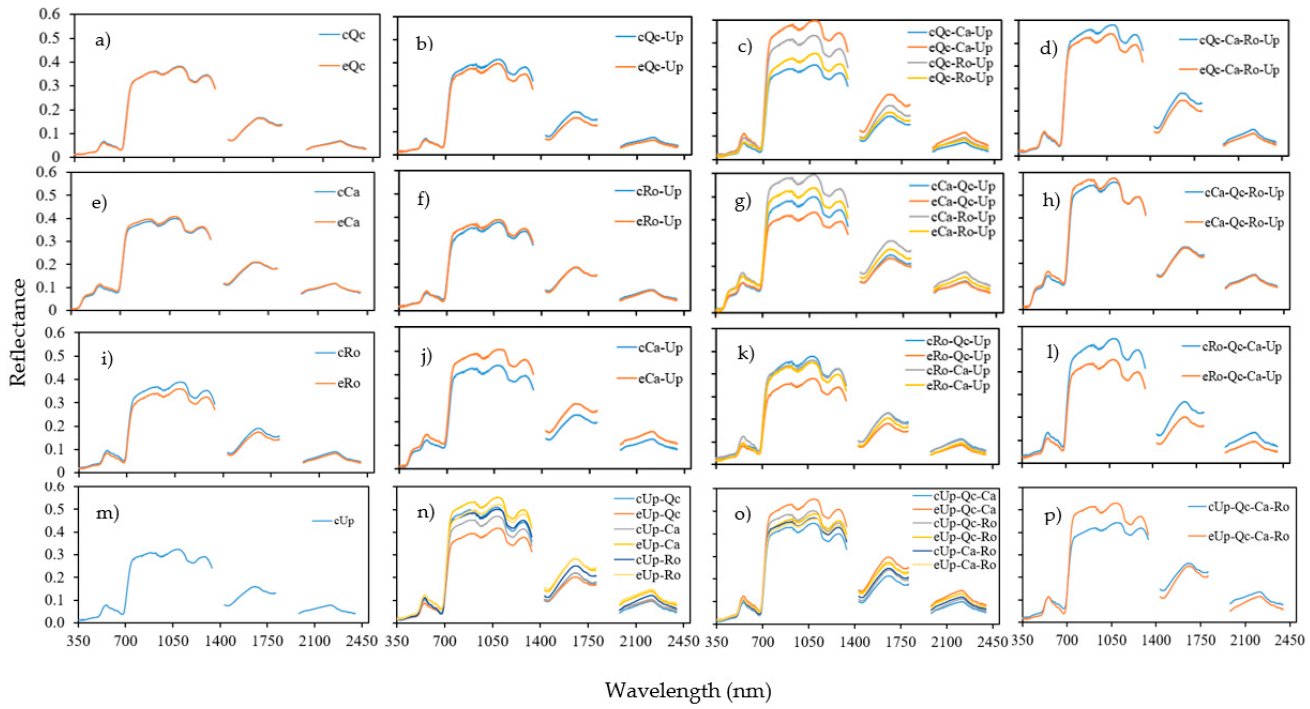
Figure 6. Spectral reflectance of assemblages in control ( c ) and exclusion ( e ). ( a – d ) Quercus coccifera (Qc); ( e – h ), Cistus albidus (Ca); ( i – l ) Rosmarinus officinalis (Ro); ( m – p ), Ulex parviflorus (Up) in monospecific. ( a , e , i , m ) Bispecific ( b , f , j , n ), trispecific ( c , g , k , o ) and tetraspecific ( d , h , l , p ). The first two letters of each assemblage indicate the measured species. Means of n = 27.